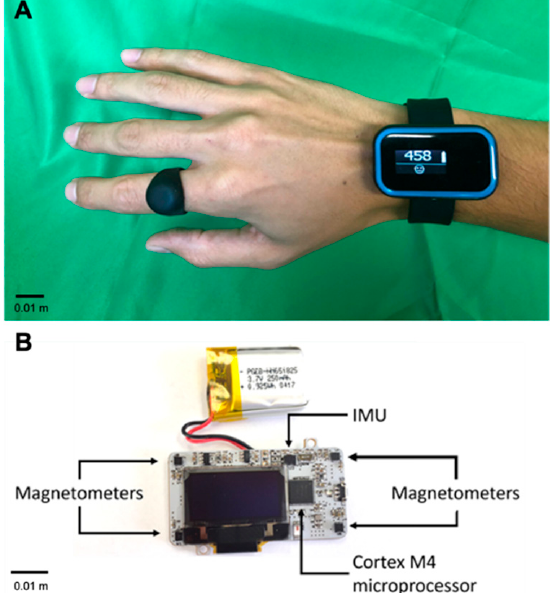
Figure 1. The Manumeter. The Manumeter with the companion magnetic ring ( A ), and the Manu- meter board ( B ), with four magnetometers positioned at the corners of the board, an IMU with 6 degrees of freedom, and a non-ferromagnetic battery. All components are controlled by a Cortex M4 microcontroller and the display showing the number 458 is an OLED